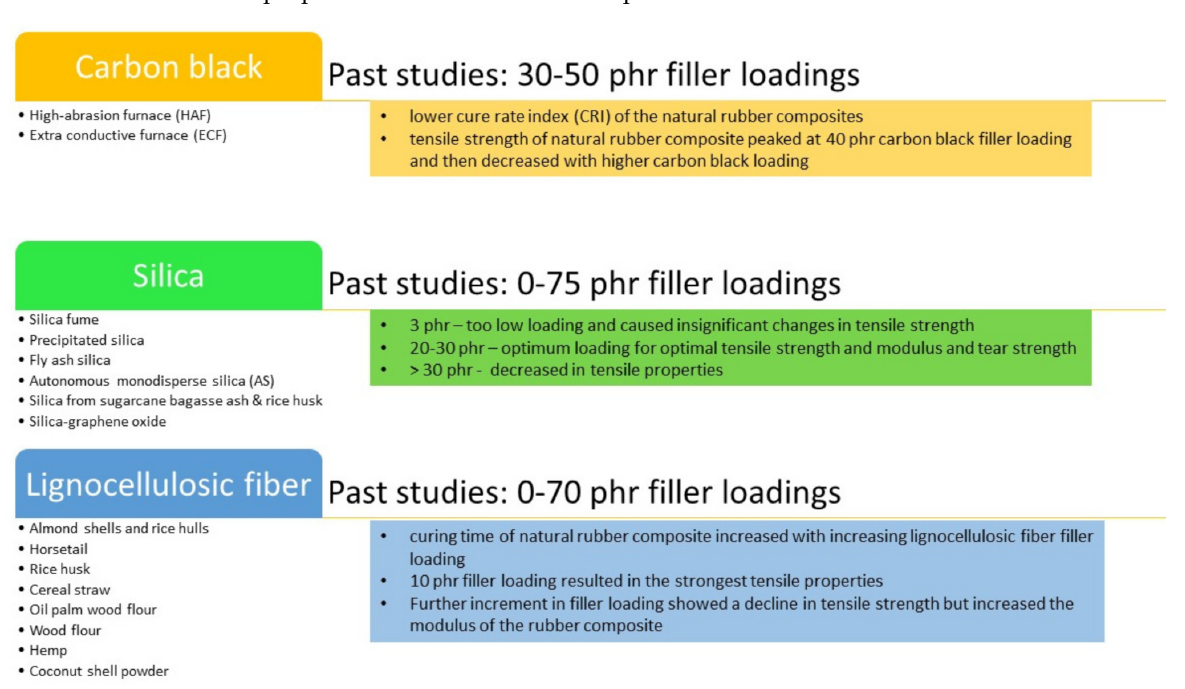
Figure 3. Summary of the effects of different types of filler and filler loadings on the properties of natural rubber